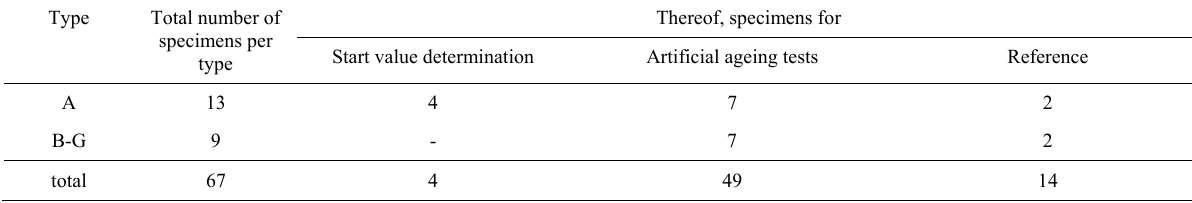
Table 2: Tested specimens according to the use in the test